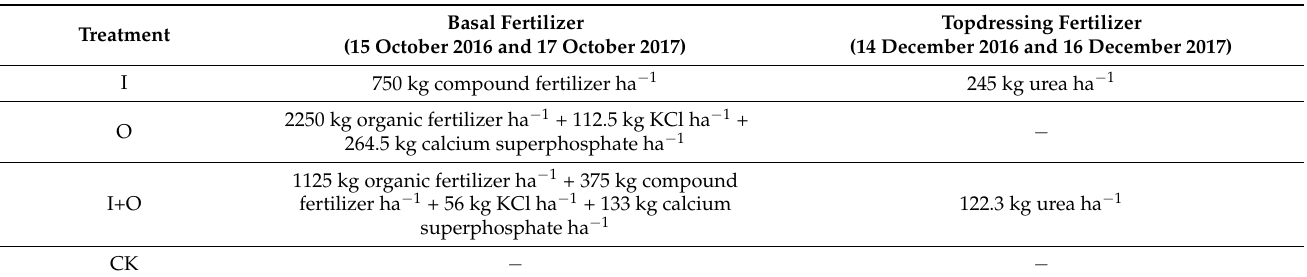
Table 1. Fertilization regimes of different